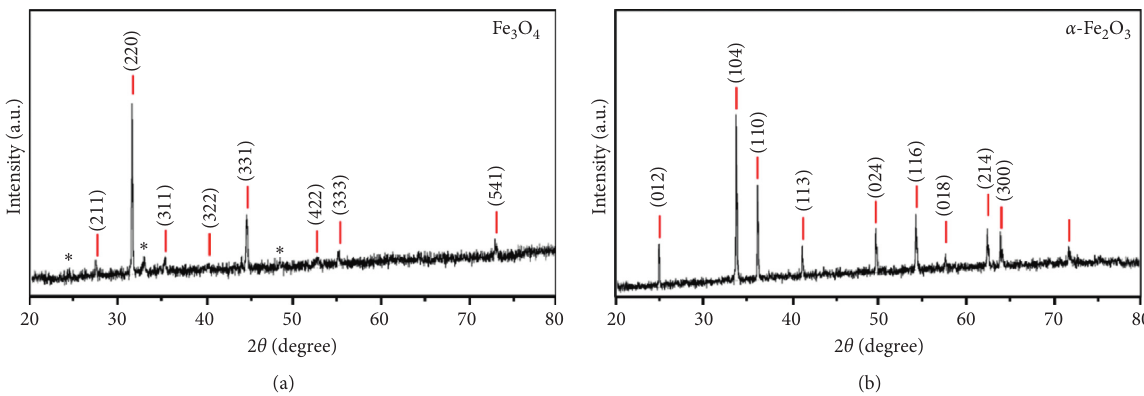
Figure 3: XRD spectra of iron oxide nanoparticles obtained from (a) chemical treatment and (b) calcination.